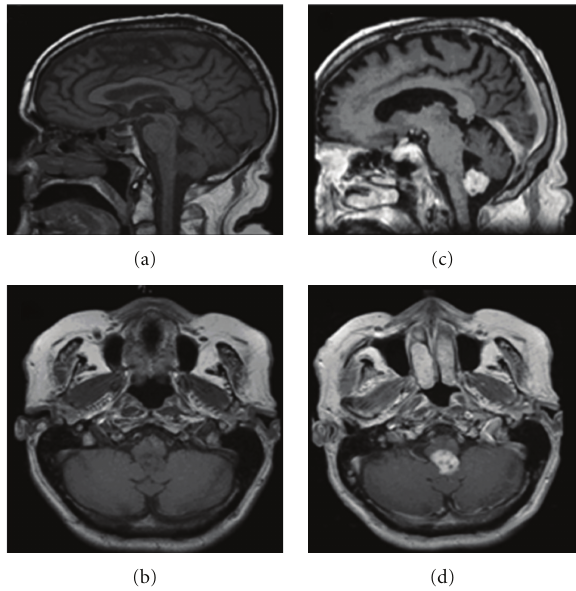
Figure 1: Sagittal and axial pre- and Postcontrast MR images. (a) Sagittal image without gadolinium showing a homogenous lesion in the fourth ventricle. (b) Axial image without gadolinium showing the lesion. (c) Sagittal postcontrast image showing a heterogeneous enhancement of the lesion. (d) Axial postcontrast also showing heterogeneous enhancement.